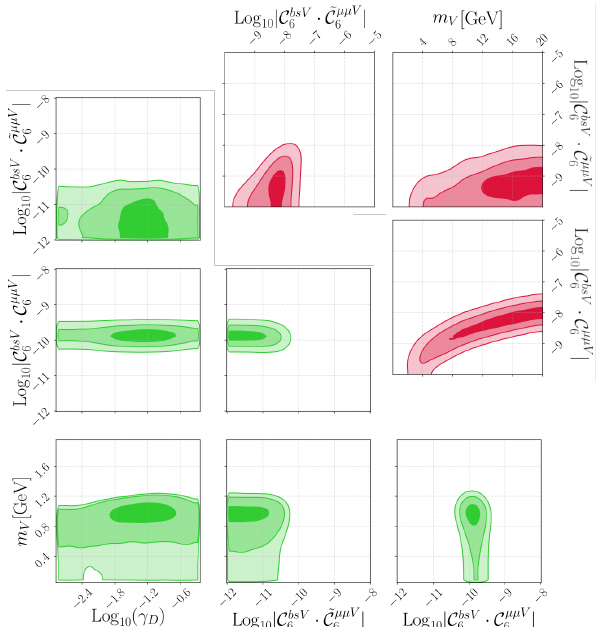
Figure 2. Inference of model parameters from a fit to b → s anomalous data with DEFT operators of dimension 6 in both the b − s and µ − µ currents ( 66 model). The colour scheme is the same as in figure 1. Note that the couplings C bsV